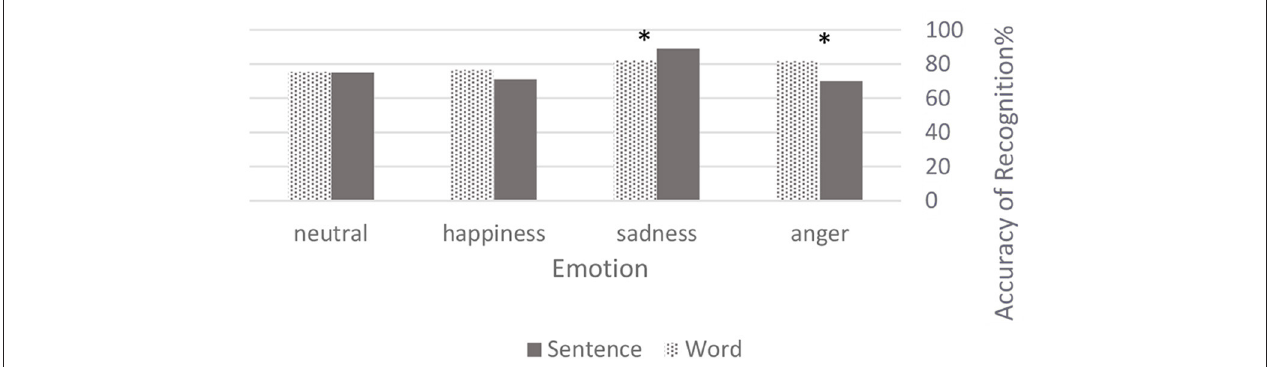
TABLE 1 | Parameters of speech analysis conducted. Anger Sadness Happiness Neutrality Total* Sentence 271 272 272 267 1082 289 290 285 289 1153 560 562 557 556 2235